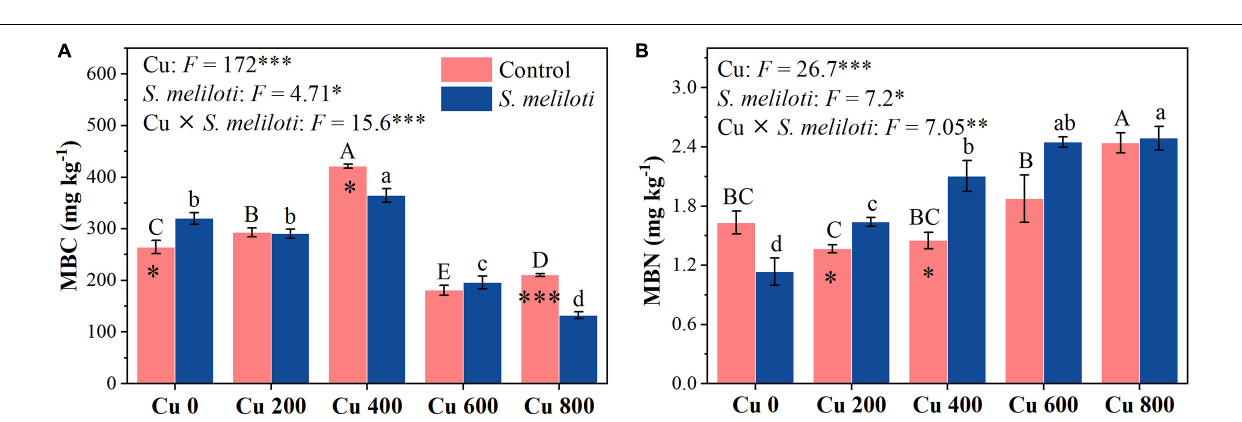
FIGURE 6 | The effect of inoculation with S. meliloti on soil microbial biomass carbon and nitrogen under different Cu concentration treatments. MBC, microbial biomass carbon; MBN, microbial biomass nitrogen. The capitalized (Cu) and lowercase ( S. meliloti ) letters above the bars indicate significant difference between different Cu concentrations ( P < 0.05). The asterisks indicate significant differences between non-inoculated and inoculated alfalfa under the same Cu concentration condition. Each value represents the mean ± SE ( n = 3). *** P < 0.001; ** P < 0.01; * P <